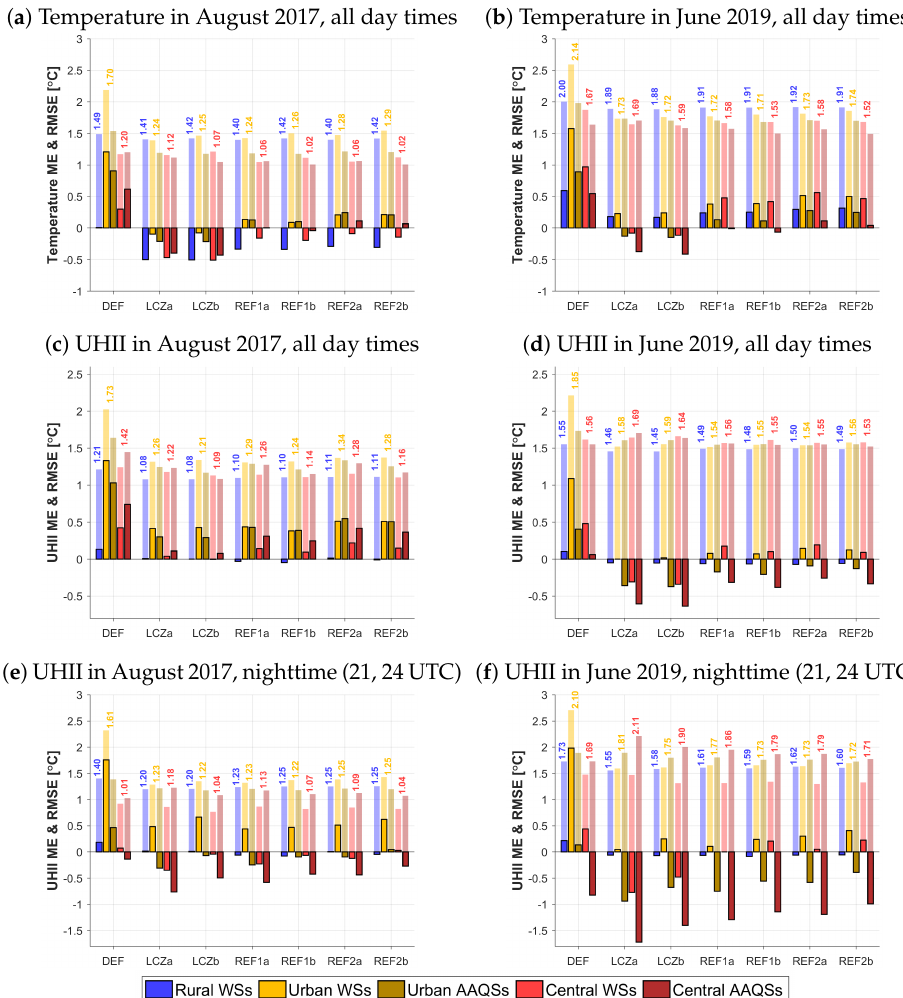
Figure 11. Model verification scores for air temperature ( a , b ) and urban heat island intensity ( c – f ) for all day times ( a – d ) and nighttime (21, 00 UTC) ( c , d ), for selected sub-periods in August 2017 ( a , c , e ) and June 2019 ( b , d , f ). The opaque bars show the ME and semi-transparent bars show the RMSE for different groups of observational sites. The digits above the bars indicate the mean RMSE for all WSs and AAQSs from the same group (rural/urban/city